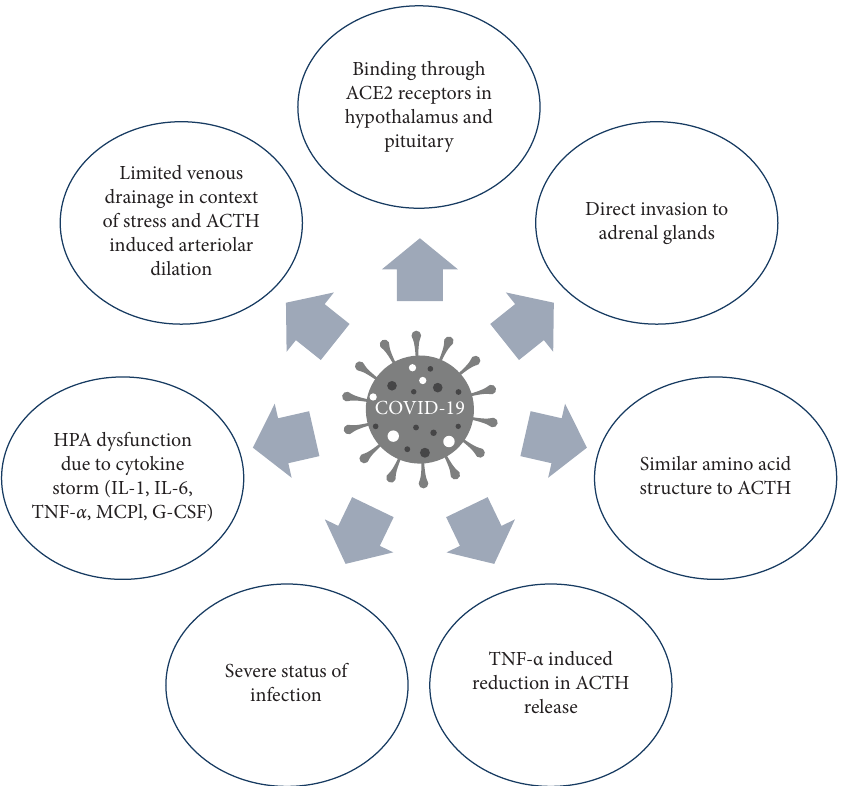
Figure 2: Summary of possible pathways of adrenal insufficiency in COVID-19 infection. ACE2: angiotensin-converting enzyme 2, ACTH: adrenocorticotropic hormone, TNF- α : tumor necrosis factor- α , IL: interleukin, MCP1: monocyte chemoattractant protein 1, and G-CSF: granulocyte-colony-stimulating